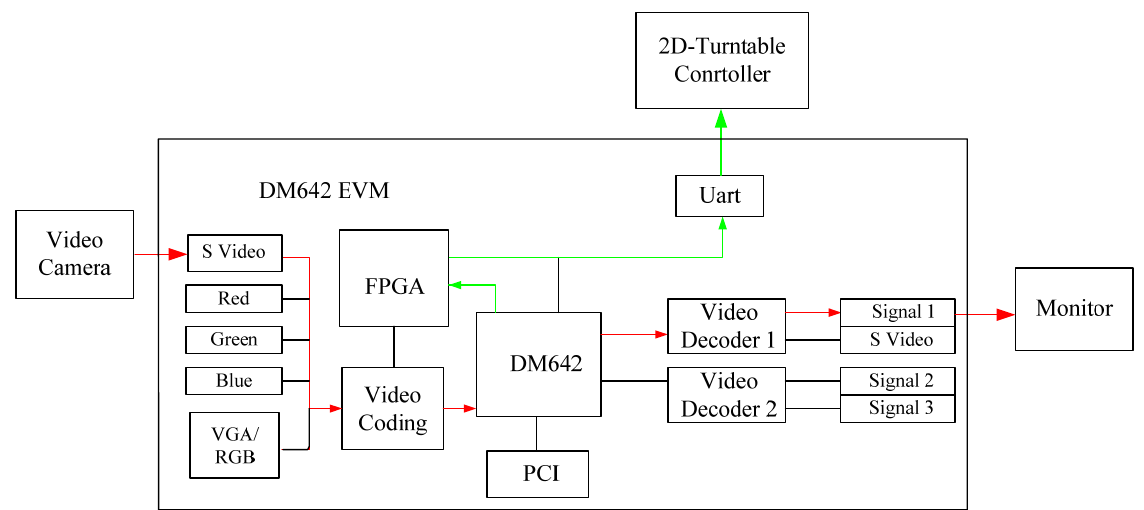
Figure 3. The structure of